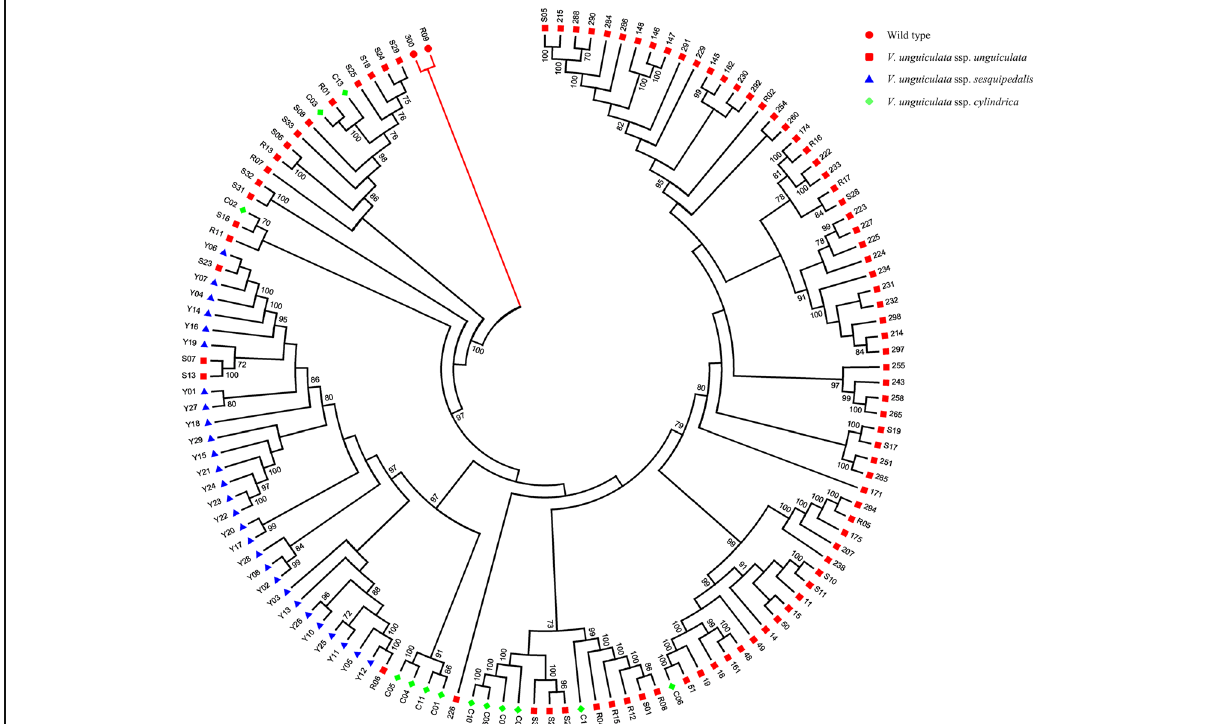
Fig. 3 Rooted phylogenetic tree of 130 accessions from three cowpea subspecies and two wild relative species. Bootstrap values > 50% are marked above